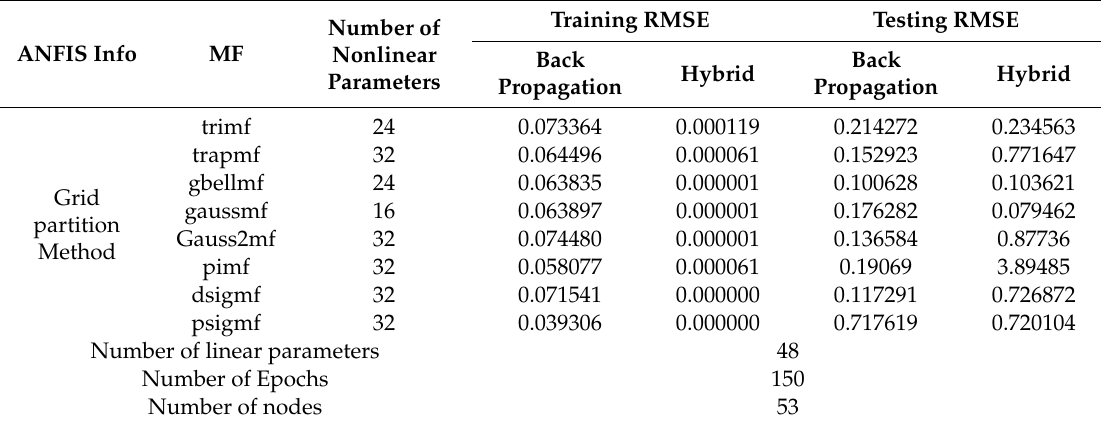
Table 6. RMSE results for di ff erent membership functions (MFs) with Membership Functions Number (4*4) from the training and testing datasets.